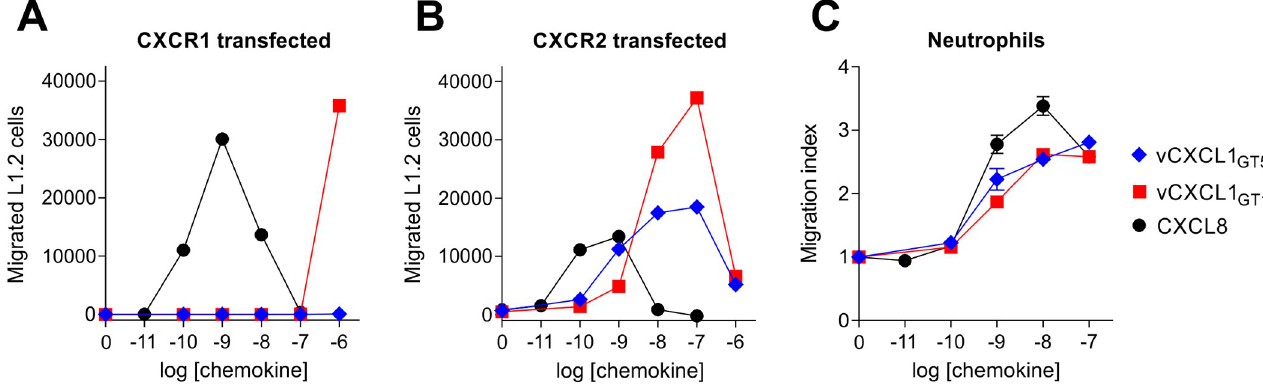
Fig 7. vCXCL1 GT1 , vCXCL GT5 and CXCL8-induced migration of L1.2 cells stably expressing either CXCR1 or CXCR2, and neutrophils. Chemotactic activities of L1.2 cells stably transfected with (A) CXCR1 (n = 4) and (B) CXCR2 (n = 3) toward vCXCL1 GT1 , wild-type vCXCL GT5 and CXCL8 in a transwell migration assay. Representative assays with error bars presented as SEM. (C) Chemotactic activity of human neutrophils toward vCXCL1 GT1 , wild-type vCXCL1 GT5 and CXCL8 in a transwell migration assay, shown as migration index (MI) determined from point measurement divided by the background measurement (n = 4). Representative assay with error bars presented as SEM.